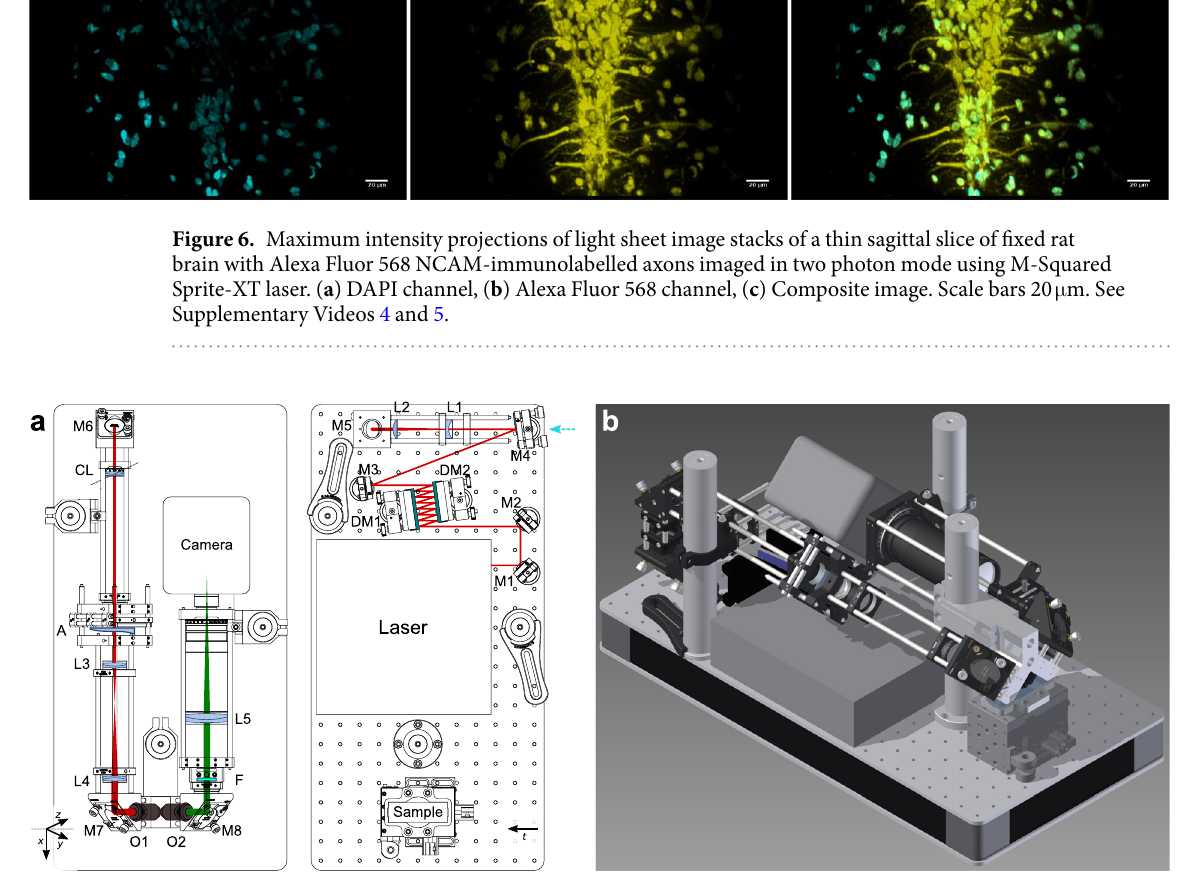
Figure 7. Optical setup with the Femtolasers Core laser oscillator. ( a ) Excitation and detection beam paths and the placement of the optical elements on 30 × 60 cm 2 breadboard in scale for using the Femtolasers Core laser oscillator. HighQ-2, M-Squared Sprite and CW lasers were coupled into the system by flipping mirror M4 (as shown by the cyan arrow). The xyz coordinate system is indicated as relative to the detection objective, the t - axis represents translation axis. The axis of the cylindrical lens CL is indicated by the dashed line. ( b ) Computer rendering of the setup. M1–M8 mirrors; DM1, DM2 dispersive mirrors; L1–L5 lenses; CL cylindrical lens; O1 excitation objective; O2 detection objective; F filters; details are given in the Methods and in the Supplementary Table